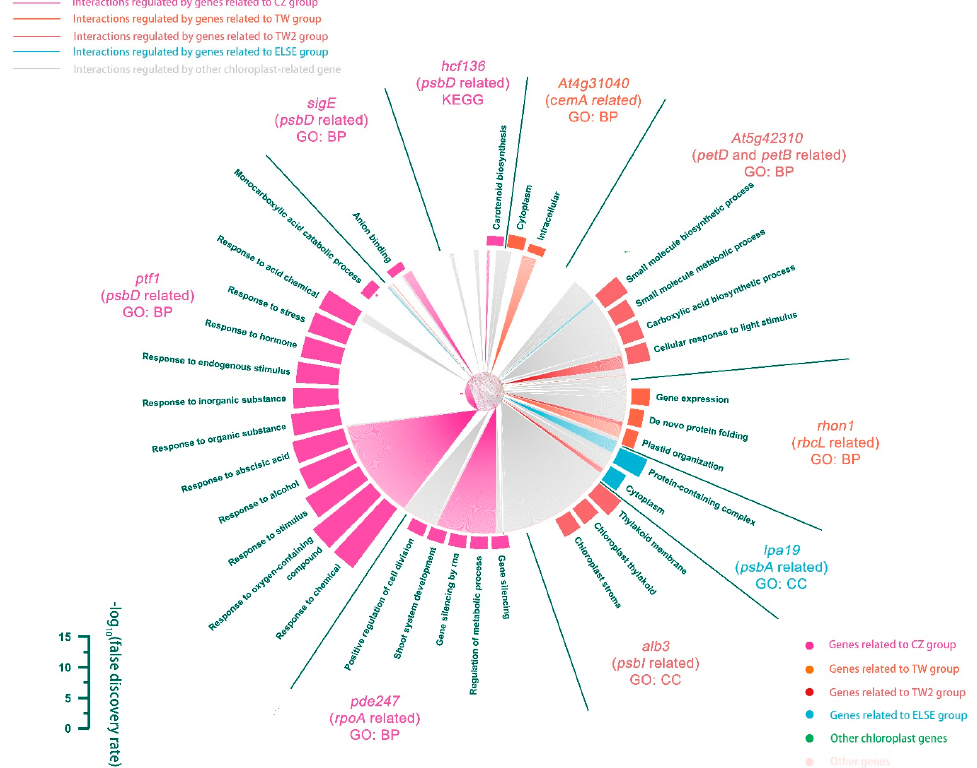
Figure 7. Gene regulatory network for the regulation between Arabidopsis thaliana chloroplast-related genes and its other genome-wide genes. The inner portion is the gene regulatory network, with different nodes representing genes related to different groups and different colored lines representing interactions regulated by genes related to the different groups. The outer portion is the circular barplot describing the functional enrichment (significantly enriched GO or KEGG terms) results of the below genes connected with the same colored lines as the bars. The regulators related to the polymorphic chloroplast genes of C. argyrophylla and the functional enrichment type of their regulated genes are marked by labels with different colors corresponding to their group classifications. CC indicates cellular component; BP indicates biological process and MF indicates molecular function. Functional annotation and enrichment analysis were conducted to explore the meta- bolic processes related to or mediated by the polymorphic, homologous chloroplast genes